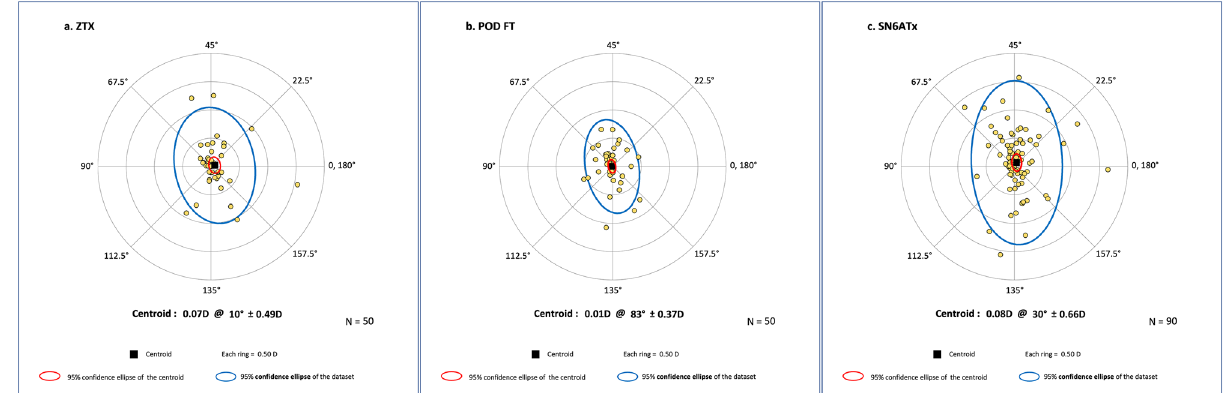
Figure 2. Double angle plots of the misalignment of: ( a ) ZXT (Johnson & Johnson Vision, Santa Ana, CA, USA), ( b ) POD FT (PhysIOL, Liège, Belgium) and ( c ) SN6ATx (Alcon Laboratories, Inc., Fort Worth, TX, USA) TIOLs. D dioptre, TIOLs toric intraocular lenses.